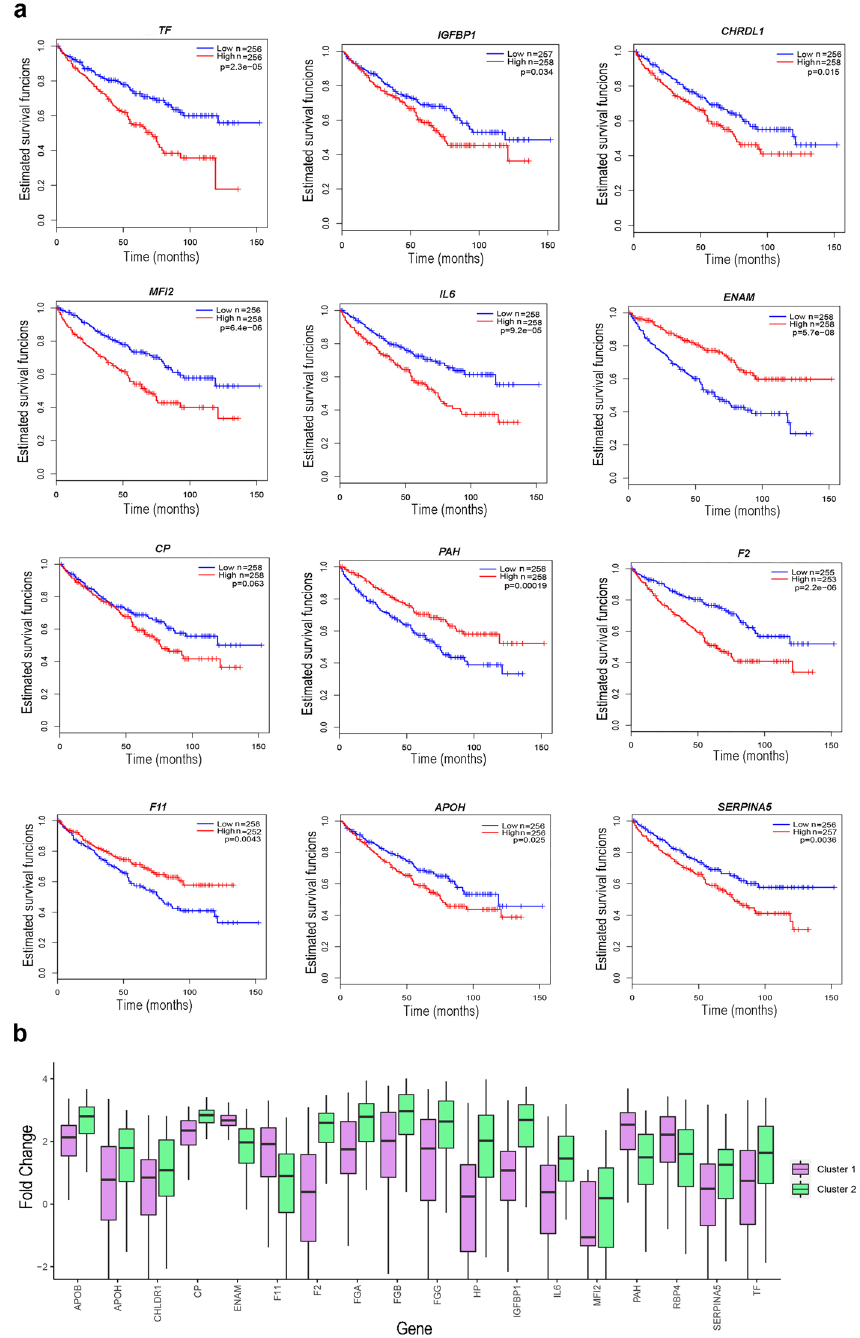
Figure 4. Survival curves by Kaplan–Meier method of ccRCC samples for hub genes of both clusters ( a ). Red indicates the group with higher gene expression, blue indicates the group with lower gene expression. The P -value of the Logrank test shows the difference in the two groups. P < 0.05 were considered significant. Changes in the expression levels of hub genes in the ccRCC samples ( b ). The rectangles represent interquartile ranges from 25 to 75 percentiles; the horizontal lines within the rectangles represent the medians. Vertical lines indicate the maximum and minimum values. P < 0.001 in each case (Wilcoxon Rank Sum